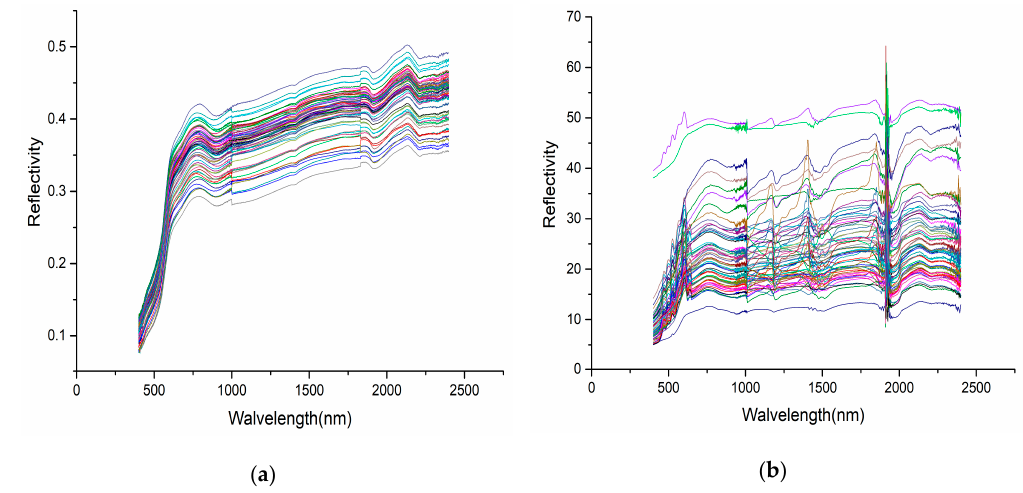
Figure 3. Soil reflectance spectra (with fringe noise removed) used to predict the As concentration in the soil: ( a ) laboratory reflectance spectra; ( b ) field reflectance spectra.